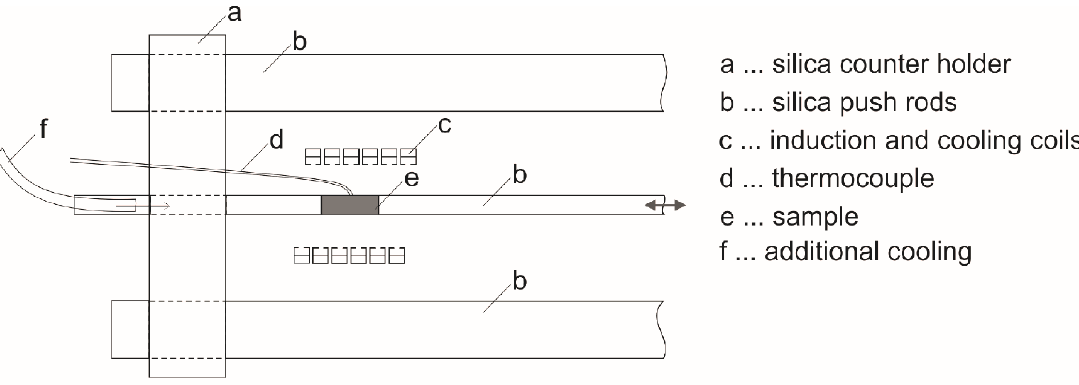
Figure 1. Schematic setup of the Bähr dilatometer in alpha-mode.